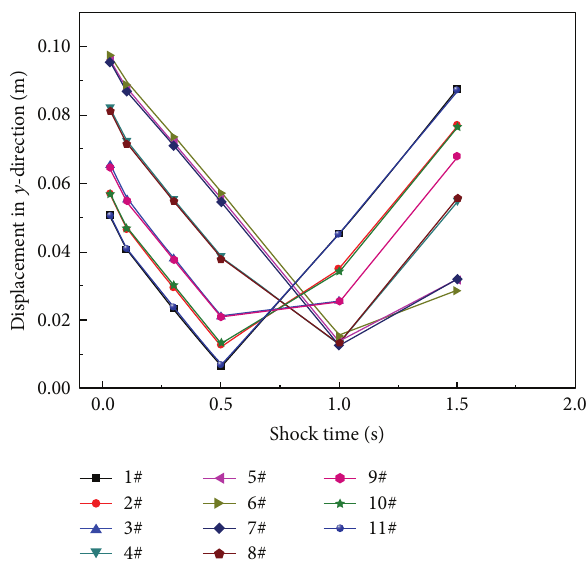
Figure6: 𝑦 -directionaldisplacementcurveswithshocktimeofeach